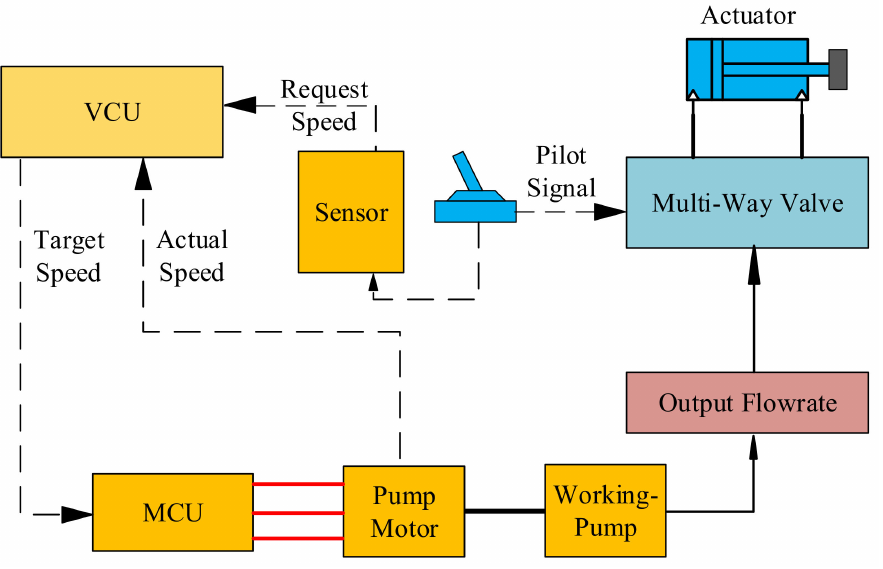
Figure 7. Framework of the positive flow